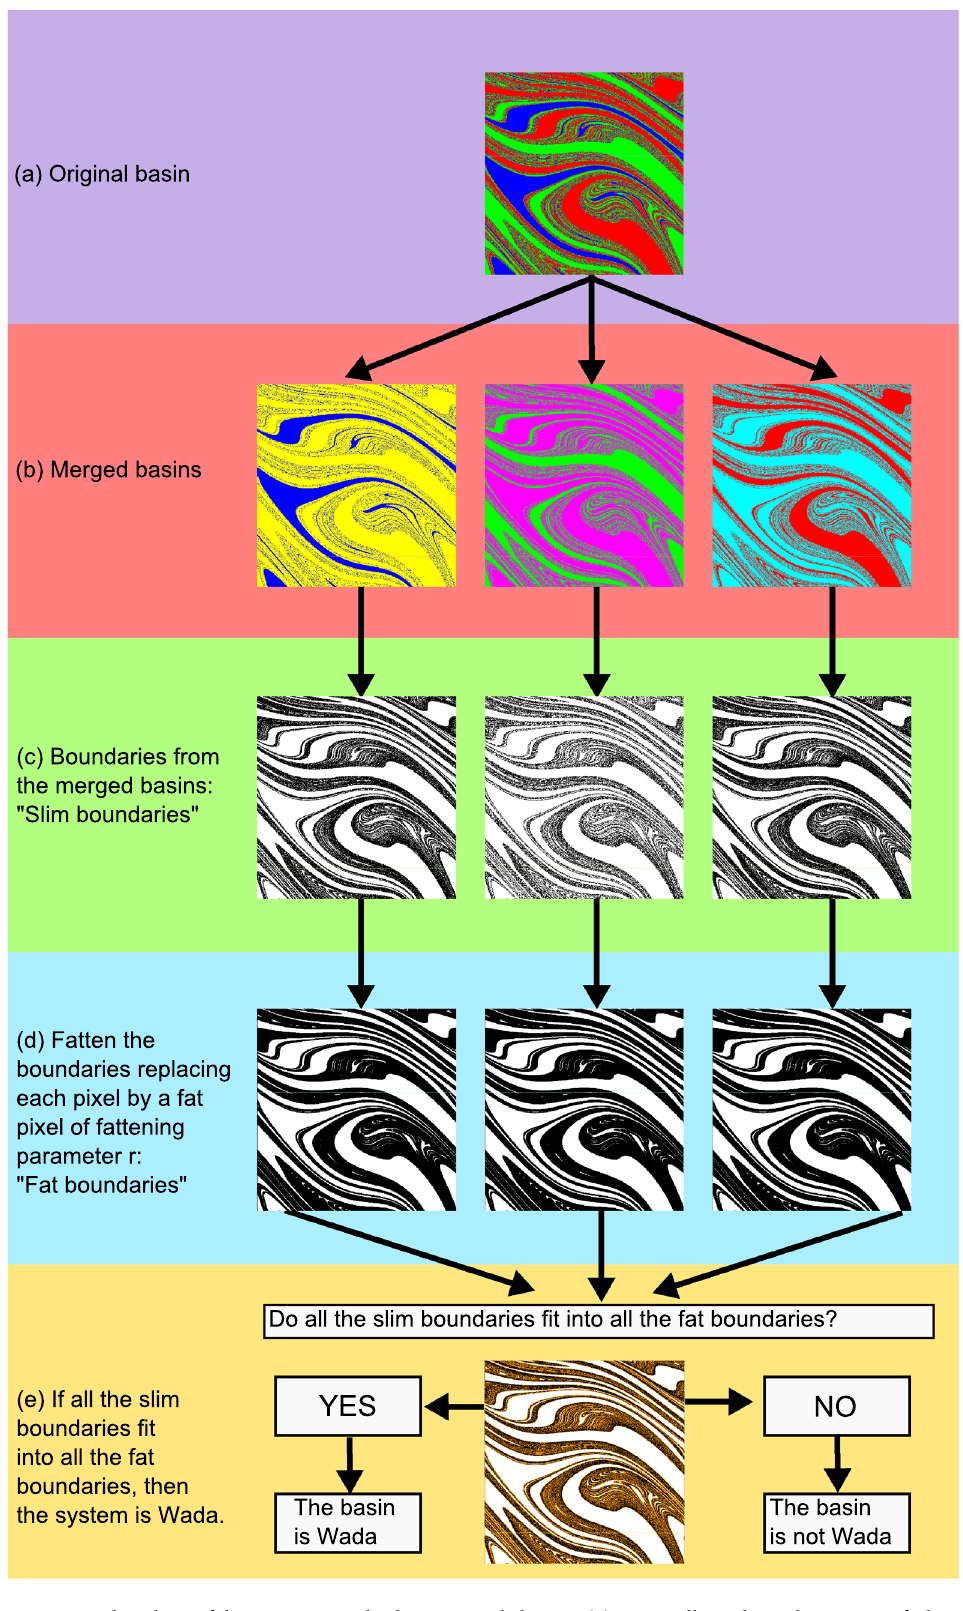
Figure 3. Flowchart of the merging method to test Wada basins. ( a ) Originally we have the picture of a basin at a given resolution. ( b ) We merge the basins, so that we have as many merged basins as different colors in the original basin. ( c ) We find the boundaries of the merged basins, which we can see they are similar but not exactly the same. ( d ) We fatten the boundaries using fat pixels of fattening parameter r . ( e ) We check if all the slim basins are contained in the fat basins. If this is the case, then the basin is Wada, otherwise, it is